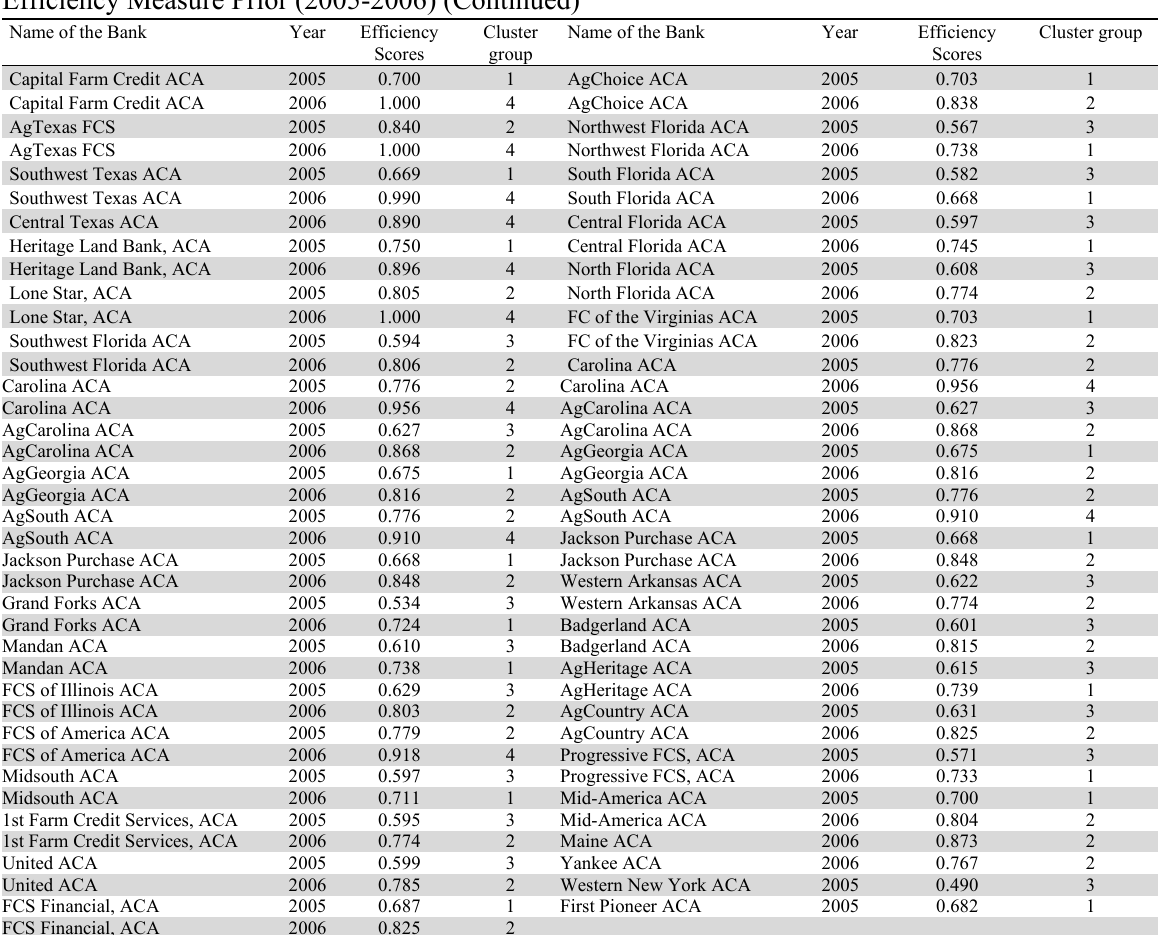
Efficiency Measure Prior (2005-2006) (Continued)